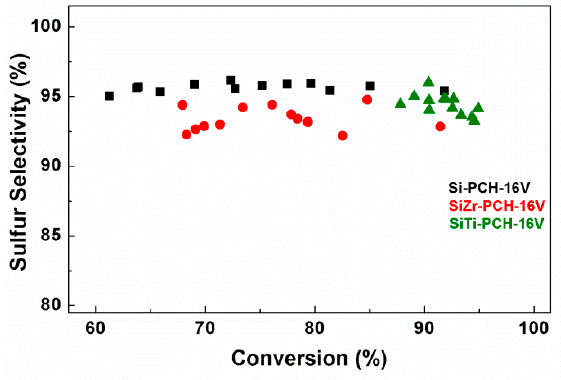
Figure 7. Variation of the selectivity to sulfur with the H 2 S conversion obtained over Si-PCH16, SiZr-PCH-16V and SiTi-PCH-16V catalysts.